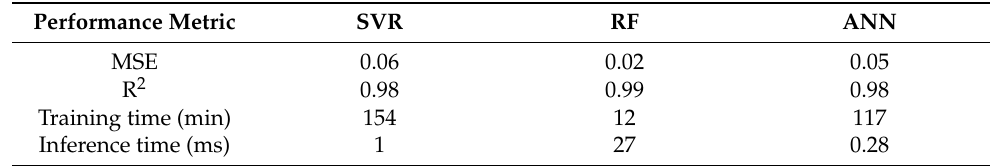
Figure 5. Comparison of the models’ correlations. Table 4. Comparison of the Models’ Performance .